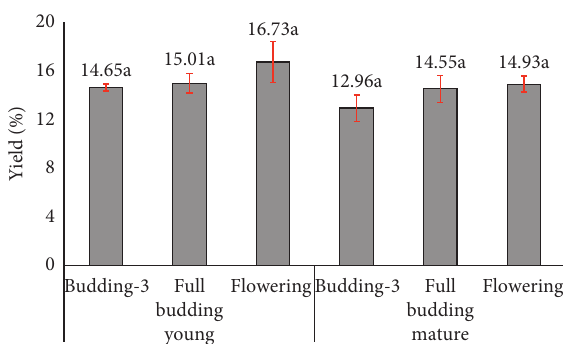
Figure 1: Yield of clove oil from three replications. Same letter notation (a, b, etc) indicates no significant difference ( p > 0.05) in each age